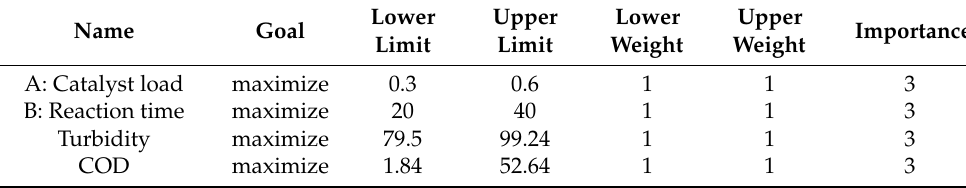
Table 8. Constraints.